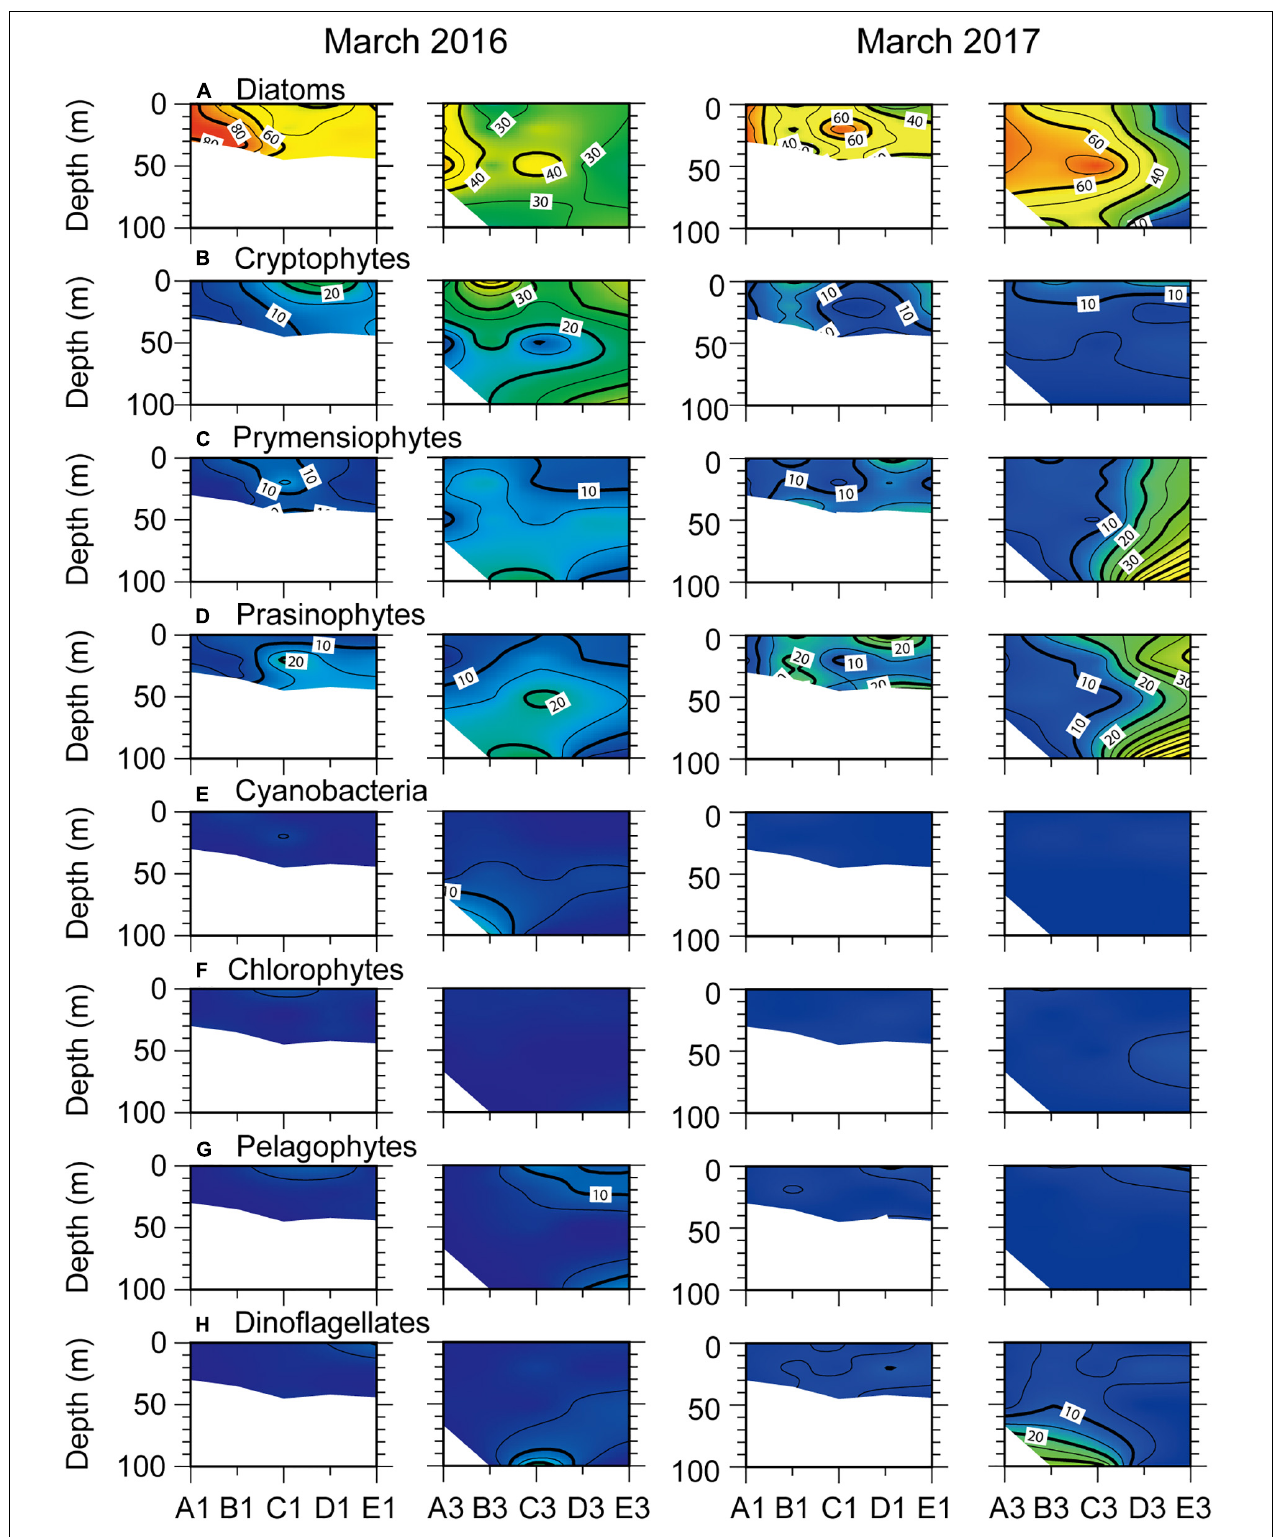
FIGURE 5 | Relative contribution (%) of different phytoplankton classes to total chlorophyll a concentrations as calculated by CHEMTAX across north–south longitudinal transects of nearshore (left) and offshore (right) stations (see Figure 1 ) in March 2016 and 2017. (A) diatoms, (B) cryptophytes, (C) prymnesiophytes, (D) prasinophytes, (E) cyanobacteria, (F) chlorophytes, (G) pelagophytes, and (H) dinoflagellates.